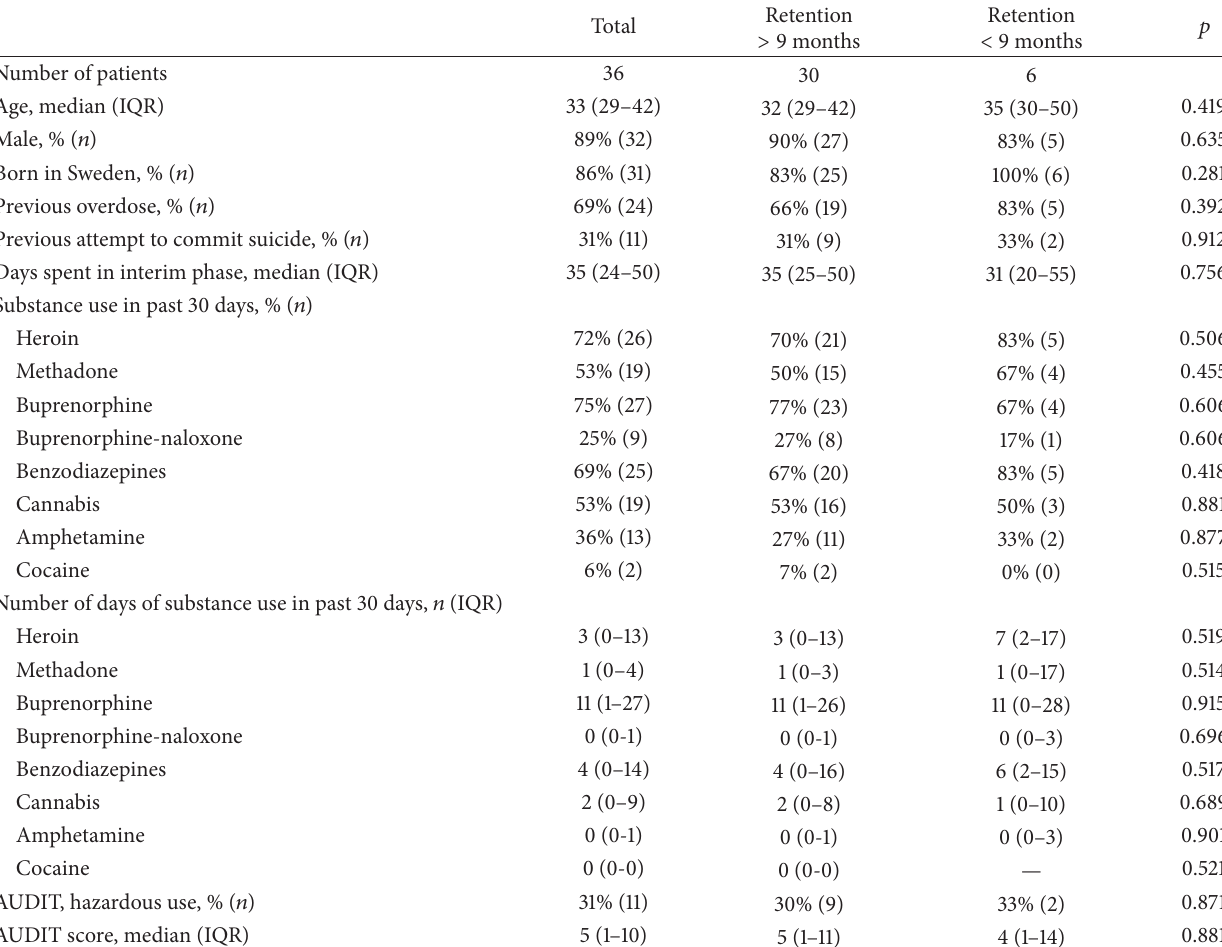
Table 1: Characteristics of subjects with and without 9-month retention in OMT after transition from buprenorphine interim